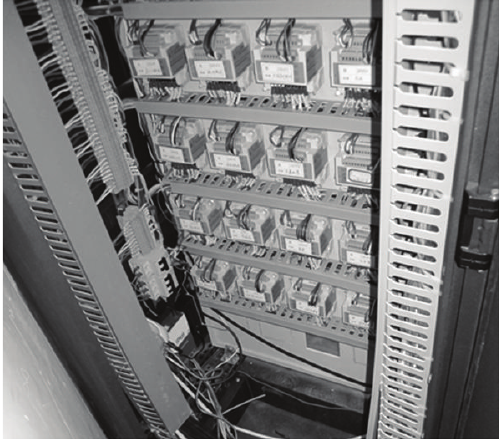
Figure 9: An example of collector installation. (3) Placement of crystals is away from the transformer and circuit line of TX and RX, and the line as shorter as possible , avoiding high frequency